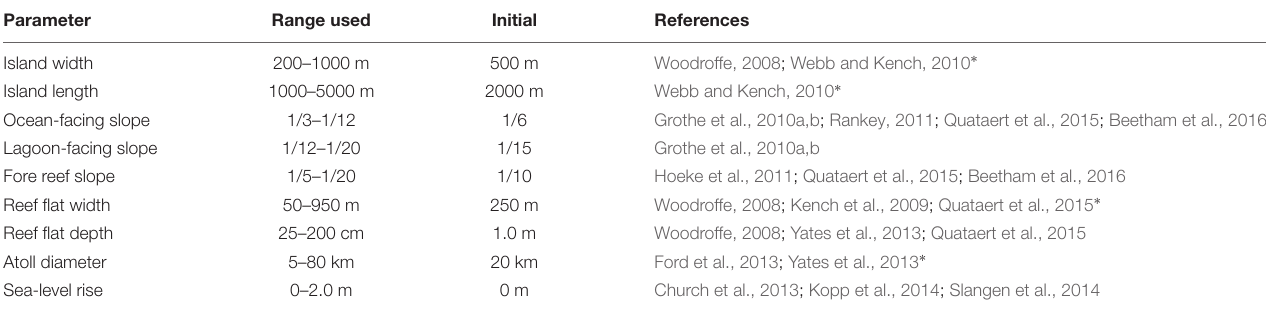
Parameter Range used